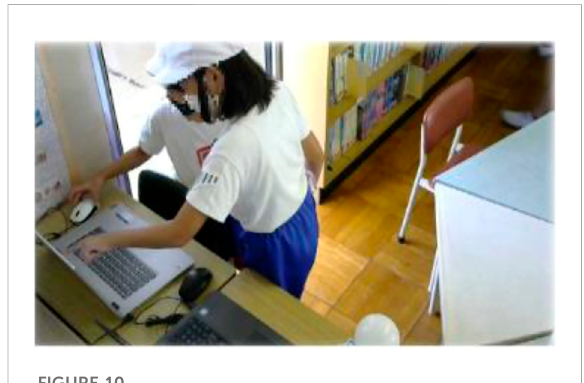
FIGURE 10 Instruction from a senior classmate and a junior